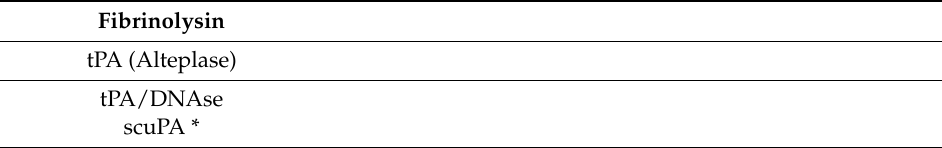
Table 1. Currently used fibrinolysins in the United